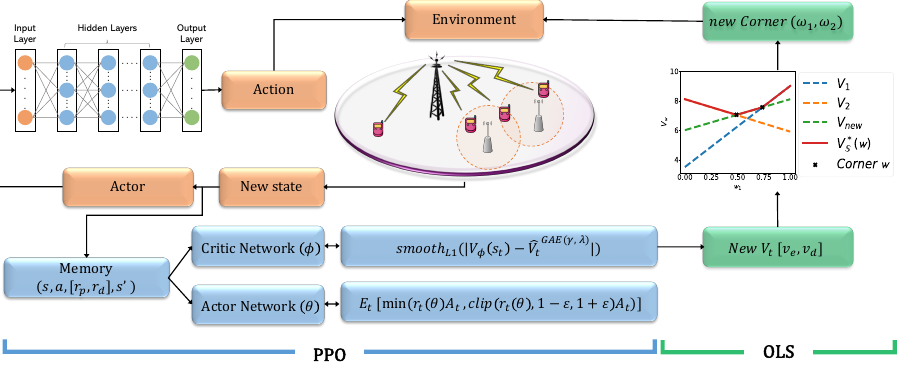
Figure 2. System architecture of the PPO-based deep OLS learning in mmWave